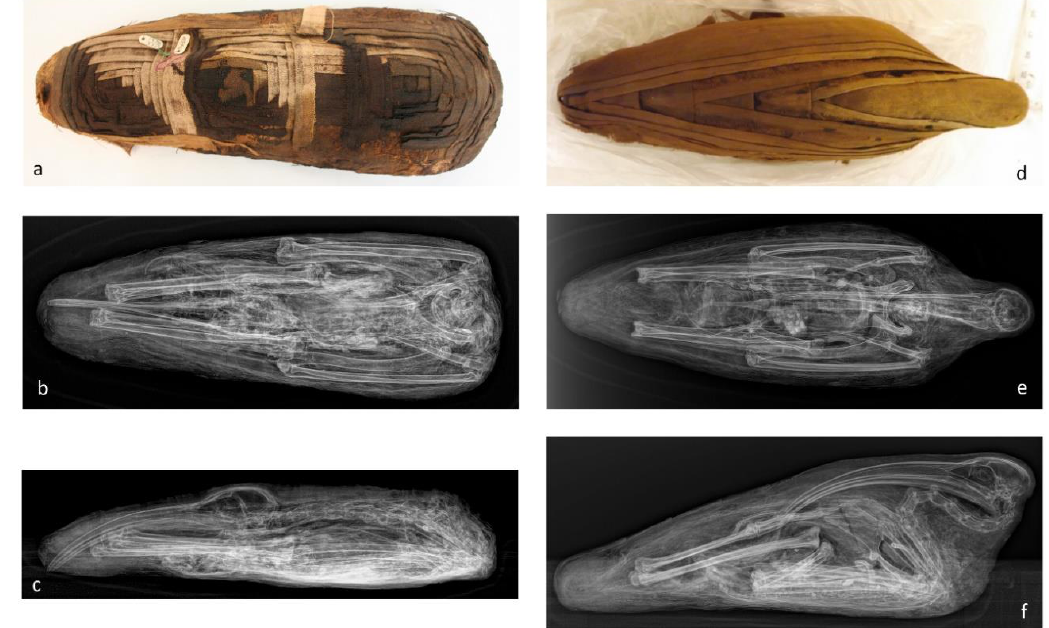
Figure 5. Figure demonstrating the two distinct bundle forms characteristic of ibis mummies from Abydos. Images ( a ) photograph, ( b ) anterior posterior radiograph, and ( c ) lateral radiograph of a Type 1 mummy (MFA acc. no. 6200.1). Images ( d ) photograph, ( e ) anterior posterior radiograph, and ( f ) lateral radiograph of a Type 2 mummy (MFA acc. no. 6200.2). [Photographs and radiographs created by author for the Ancient Egyptian Animal Bio Bank.].